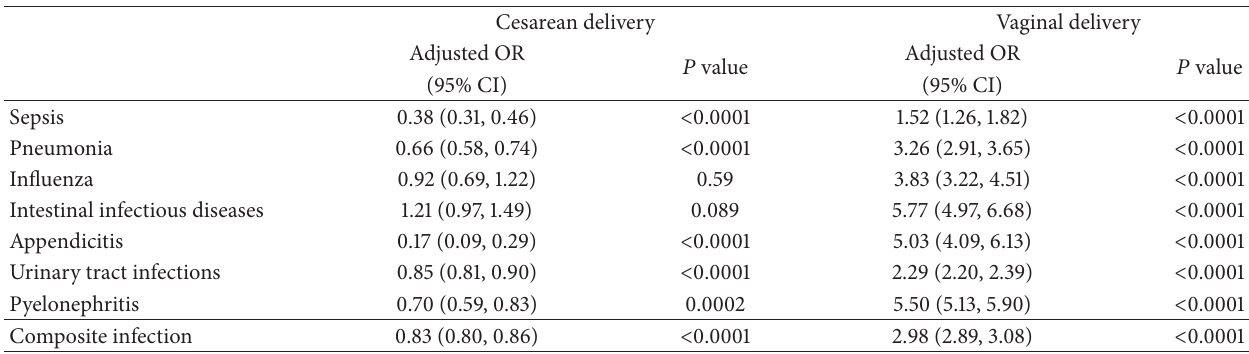
Table 5: Multivariable logistic regression analysis by mode of delivery for the listed infectious outcomes among women with multiple gestations compared to women with singleton gestations while controlling age, race/ethnicity, insurance status, length of hospital stay, chronic hypertension, gestational diabetes, diabetes, asthma, HIV, systemic lupus erythematosus [19], collagen vascular disease, anemia, thrombocytopenia, and preterm